Question: In one sentence, what is this figure communicating?
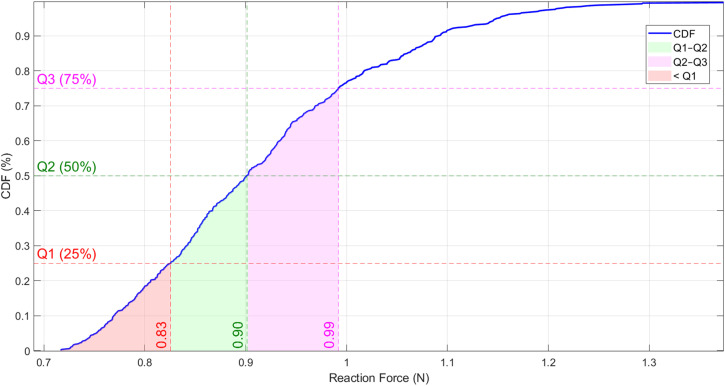
Answer: Cumulative density function (CFD) evaluating the reaction force (RF) variability across the 500 aneurysm morphologies. This function illustrates the probability of a randomly selected geometry requires an insertion force being below a specific threshold. The data are split into quartiles for qualitative visualization: Q1 (25%), Q2 (median, 50%), and Q3 (75%).